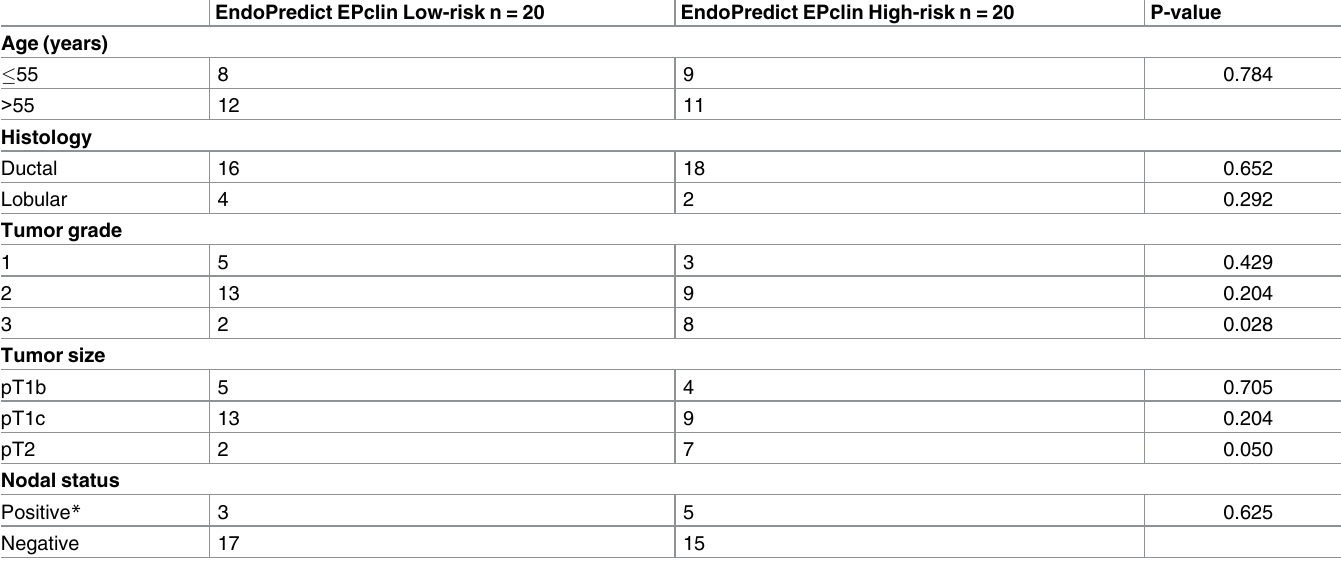
Table 2. Clinical characteristics of the patients classified as high- or low-risk for distant metastasisby EPclin score.